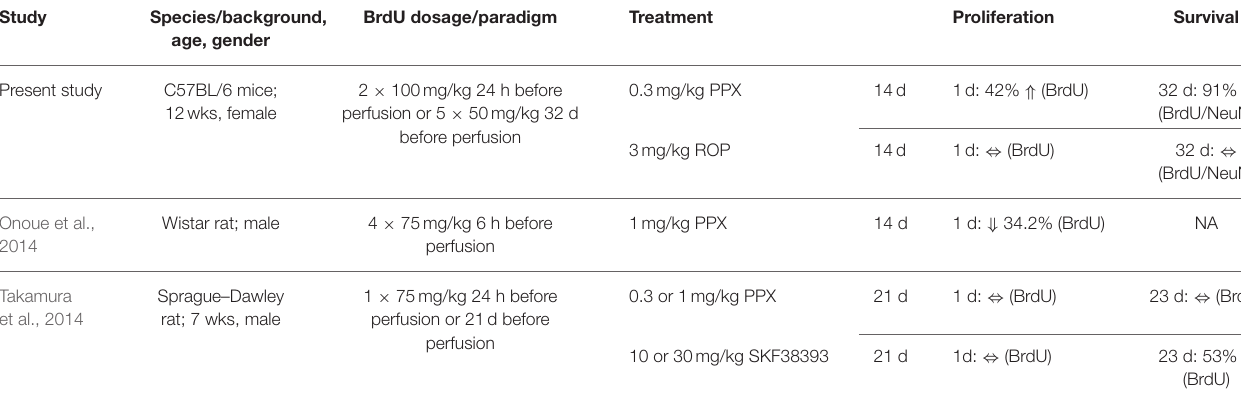
Values indicate the percentage increase or decrease of BrdU + and BrdU + /NeuN + cells in the DG compared to the control groups of the respective studies. The age of the animals at the beginning of the experiments is given. ⇔ ; no effect vs. control, ⇑ : increased effect vs. control; ⇓ :: reduced effect vs. control. NA, not applicable, d, days, wks: weeks, BrdU, 5-bromo-2 ′ -deoxyuridine; NeuN, neuronal